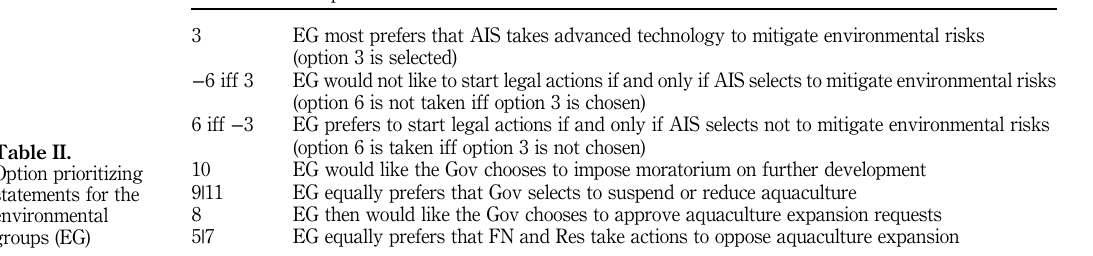
Table II. Option prioritizing